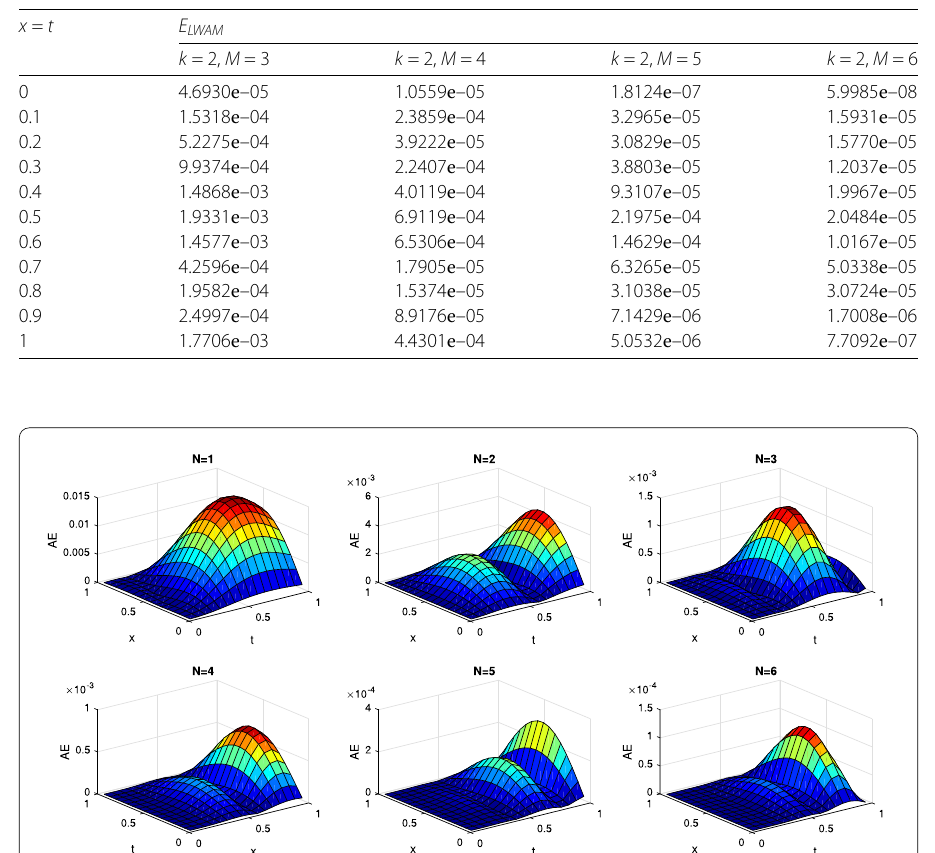
(cid:31) 1 . We solve (48) for k = 3 and –15 t +6 x (cid:19) 4 +1 e 6 u i ( x , t ). We i =0